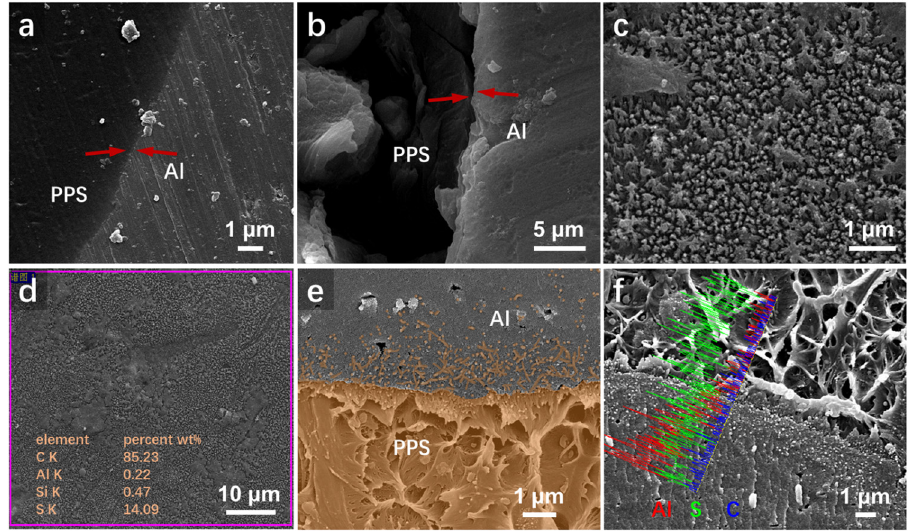
Figure 5: The SEM images of PMH interface. The cross - section image of PPS/Al boundary in which the Al plate was anodized for 6 h at 15 V ( a ) and 20 V ( b ) . ( c ) The exposed PPS surface of PMH after dissolving the Al matrix, ( d ) the element mapping of ( c ) , ( e ) the front image showing the anchor and bolt structure that constructed by PPA and Al, where the PPS was rendered yellow, and ( f ) the element distribution around